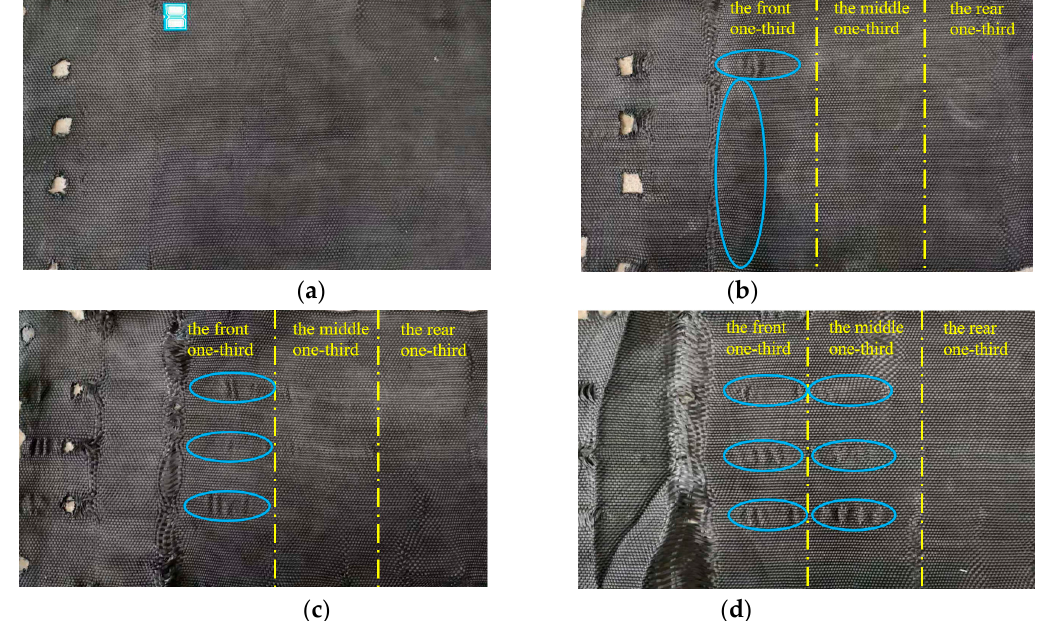
Figure 8. T-type interface after the pull-out test. ( a ) 25 kPa normal stress. ( b ) 50 kPa normal stress. ( c ) 75 kPa normal stress. ( d ) 100 kPa normal stress.